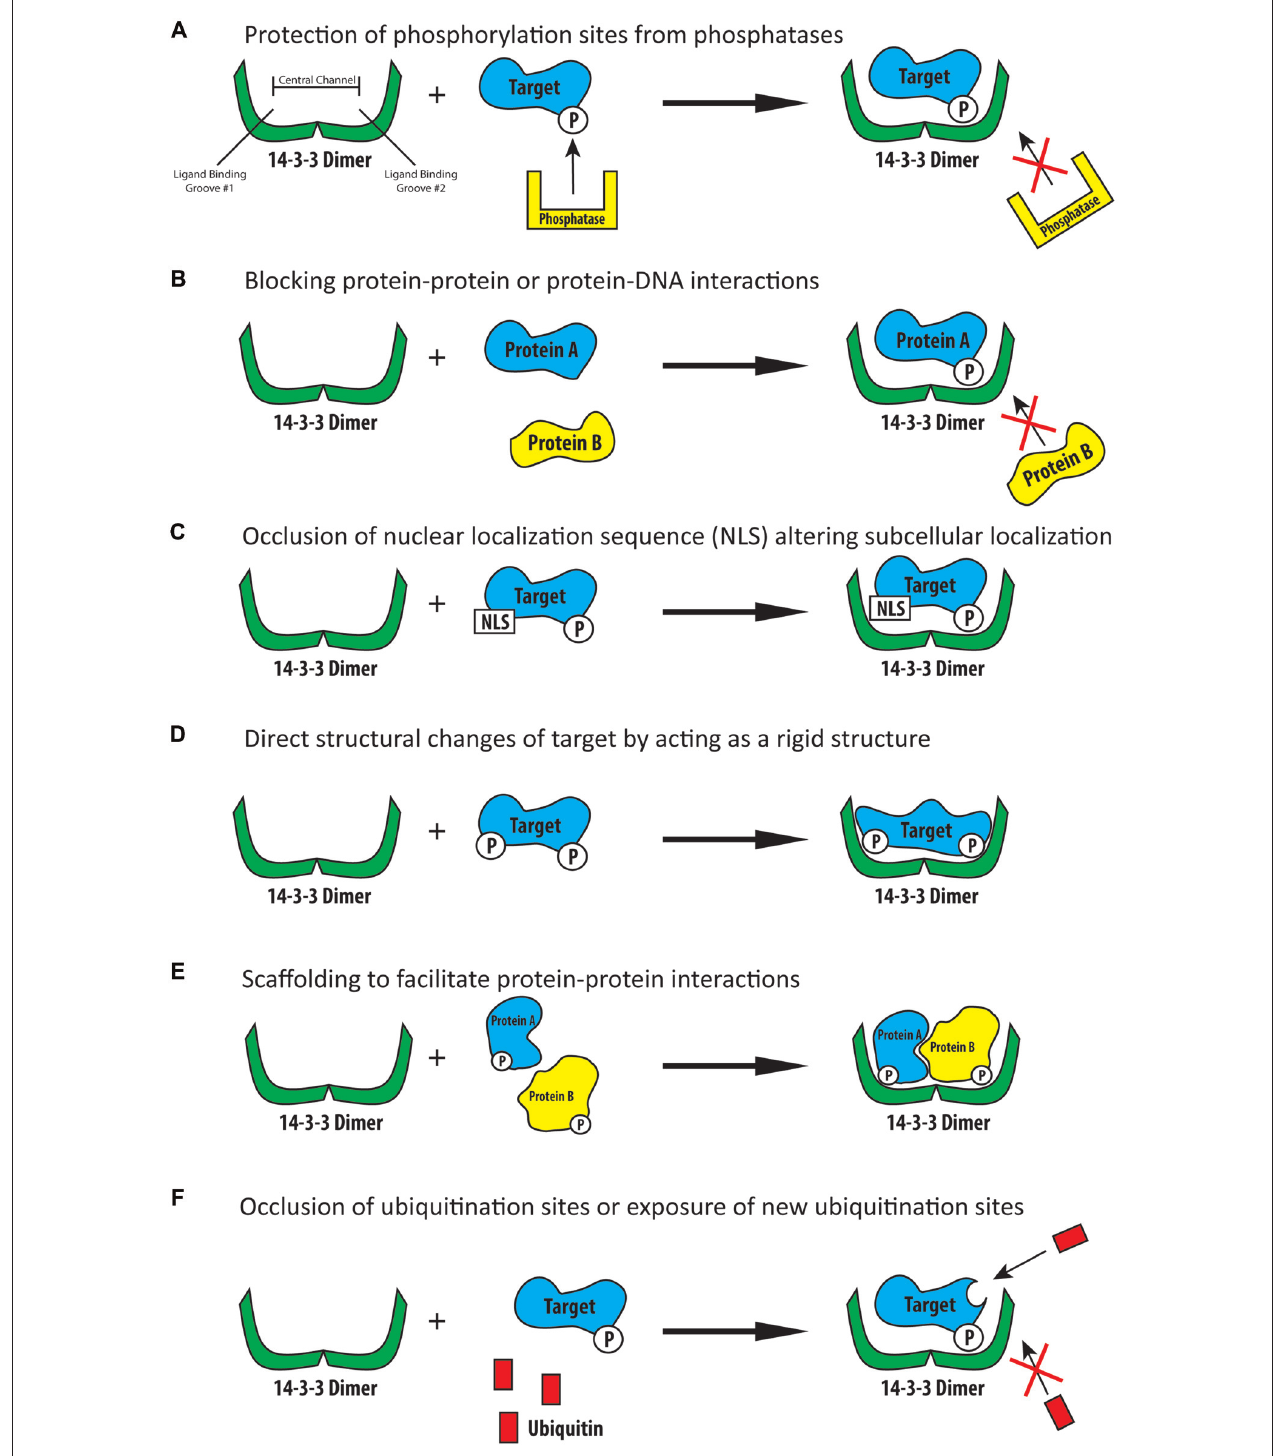
FIGURE 1 | Schematic illustration of some of the known functions of 14-3-3 proteins. (A) 14-3-3 proteins are able to bind phosphorylated targets and prevent their dephosphorylation by phosphatases. (B) 14-3-3 proteins can bind phosphorylated targets and block protein-protein or protein-DNA interaction sites. (C) 14-3-3 proteins are able to bind their targets and block localization signals, including nuclear localization signals, thus altering their targets subcellular localization. (D) 14-3-3 proteins can produce direct conformational changes on their targets by acting as rigid structures. (E) 14-3-3 proteins can act as rigid scaffolding structures and bind multiple targets to bring them into close proximity to one another. (F) 14-3-3 proteins can bind their target and block ubiquitination sites thus preventing the subsequent degradation of their target or they may bind their target and increase ubiquitination and subsequent degradation.